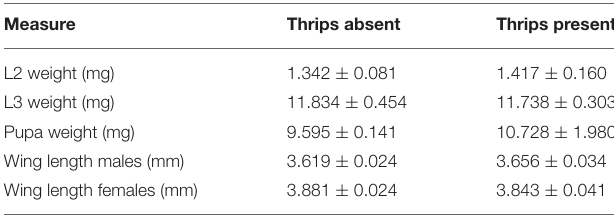
TABLE 1 | Morphological traits of S. rueppellii when fed on M. persicae with and without the presence of F. occidentalis .